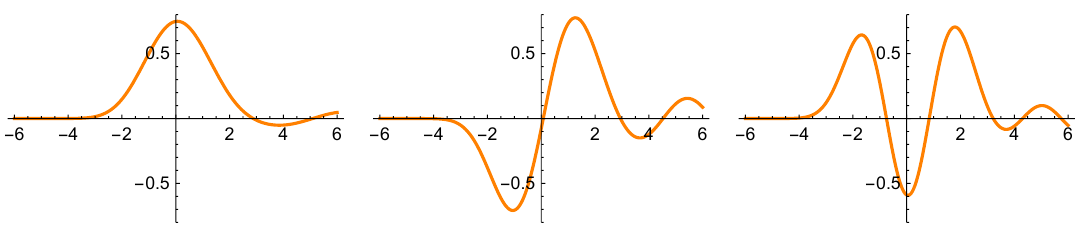
Figure 8. Gauge theory 2-particle Toda solution (cid:9) a ( x ) for Q = 1, ~ = 1 : 5 at a not solving the